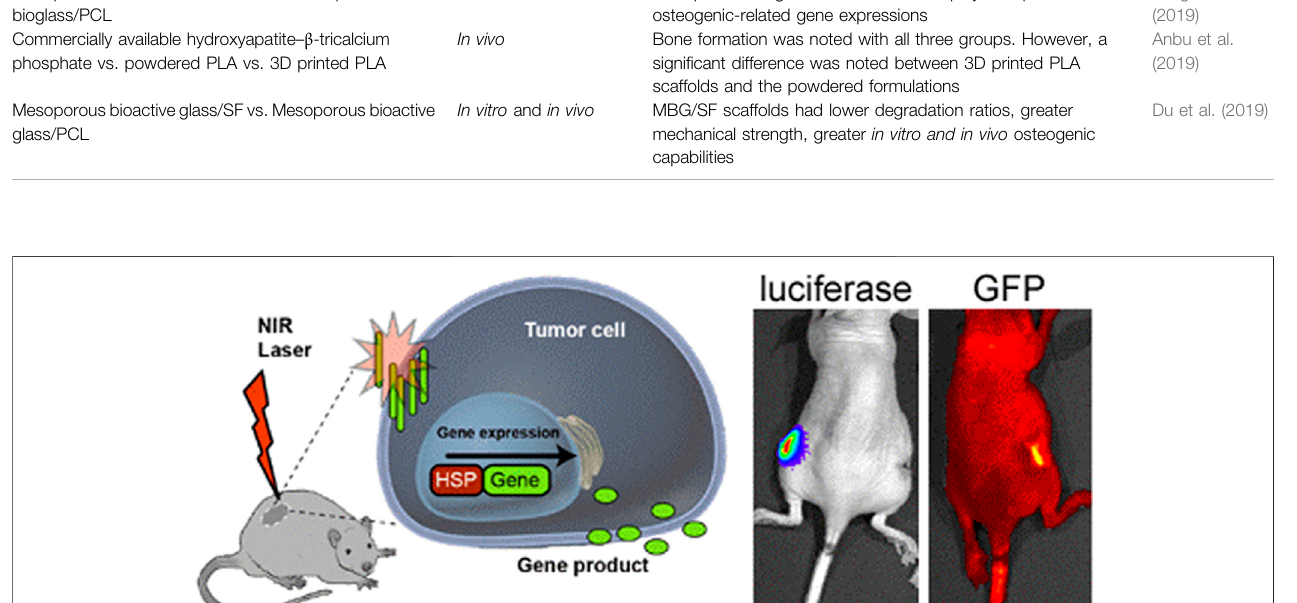
FIGURE 2 | Schematic depicting the use of NIR laser to trigger photothermal effects in tumor cells. HSP- Heat shock protein. Reproduced from Andersson et al. (2014) under Creative Commons Attribution license (CC BY-NC-SA 3.0) (http://creativecommons.org/licenses/by/3.0/).